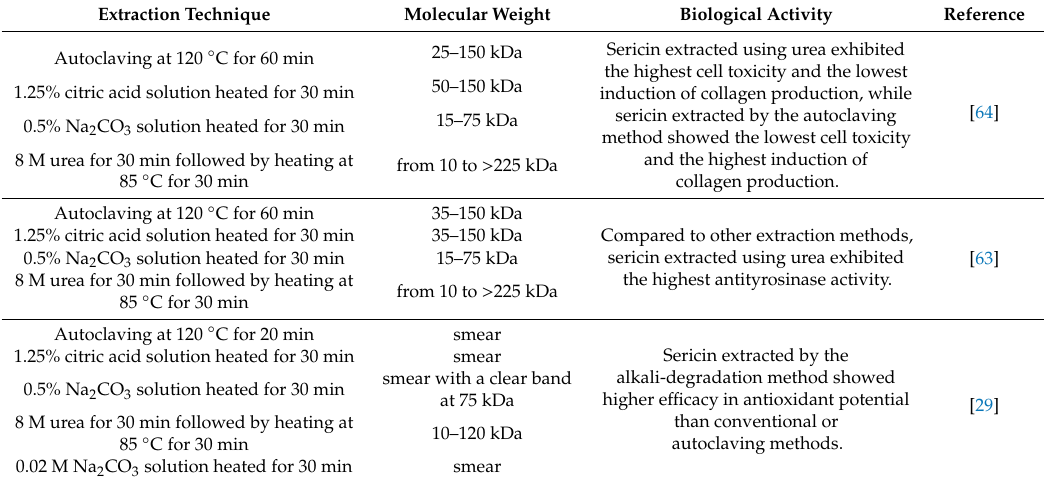
Table 2. Molecular weight and biological activity of sericin according to the degumming method